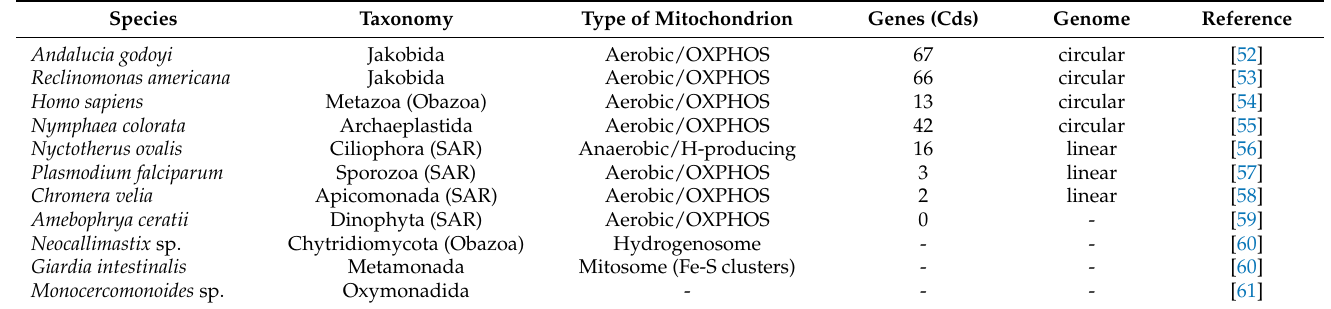
Table 2. Examples of mitochondria and MROs and their characteristics in various eukaryotes. It demon- strates the reductive evolution of mitochondria, from mitochondrial organelles with large genomes to hydrogenosomes and mitosomes lacking genome and eukaryotic cells without